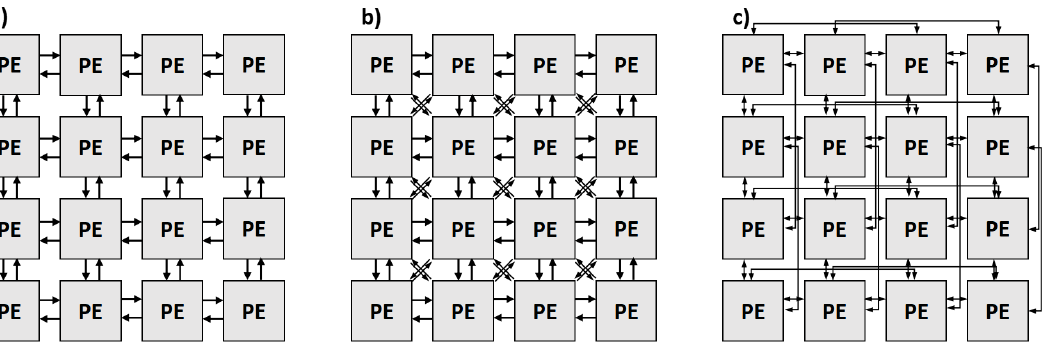
Figure 4. Mesh-based communication patterns with direct NESW (North-East-South-West) connec- tions between PEs ( a ) and expanded versions with additional diagonal connections ( b ) and extended distance NESW ( c